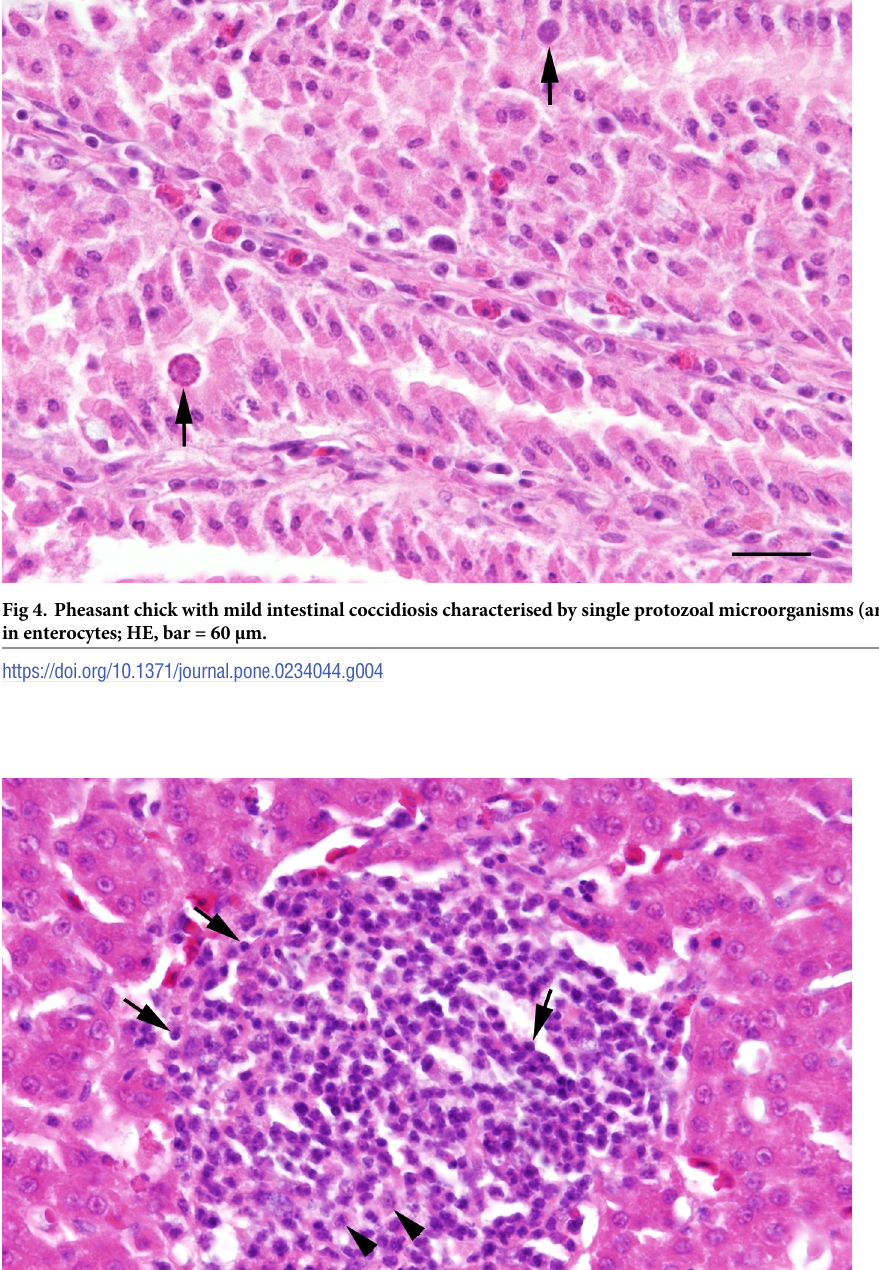
PLOS ONE | https://doi.org/10.1371/journal.pone.0234044 June 16,